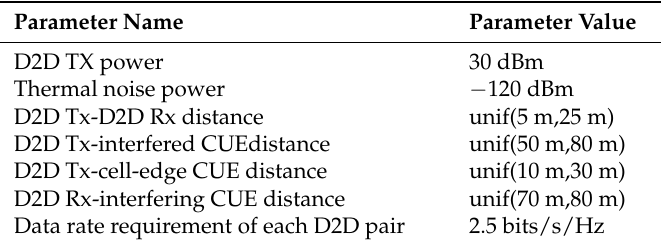
Table 1. The simulation